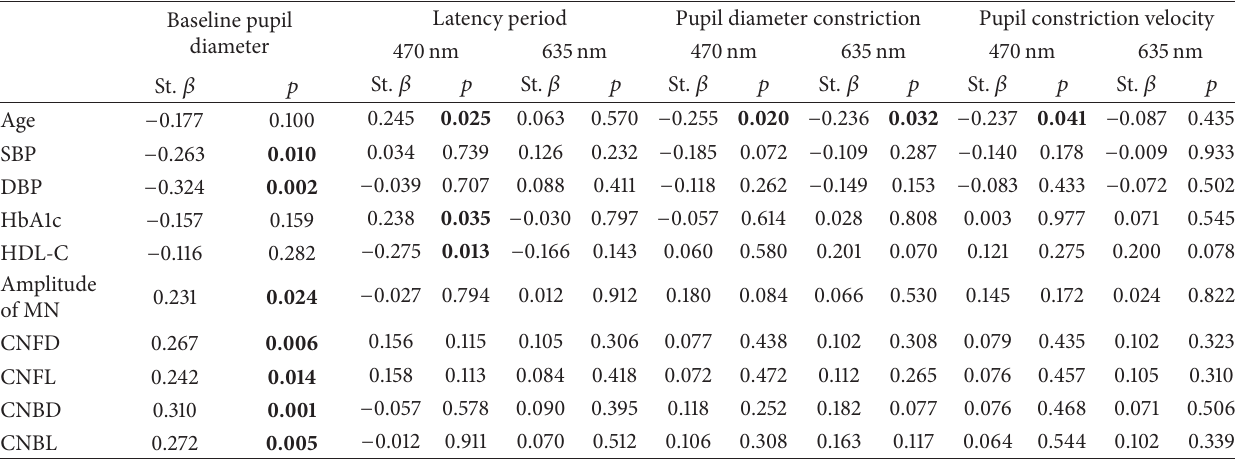
Table 5: Relationship between the parameters of pupillary light reflex and clinical factors, neurophysiological tests, or corneal nerve fiber measures in total type 2 diabetic